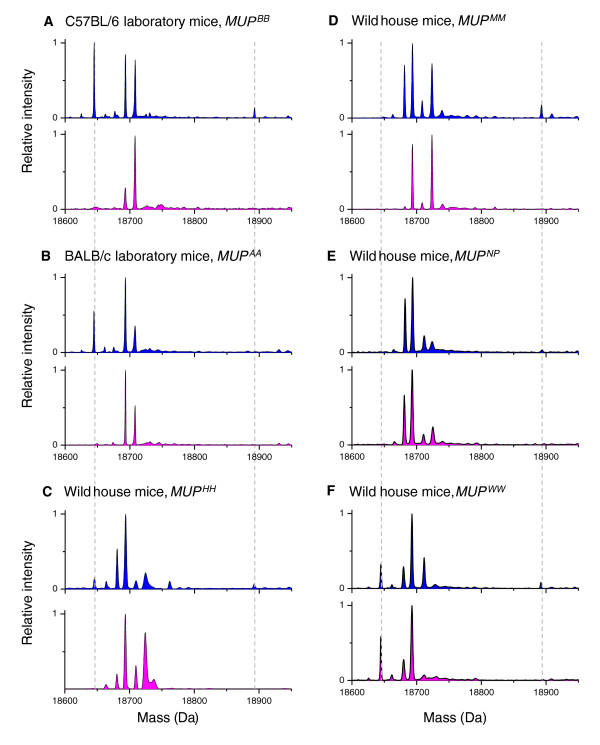
Variation in expression of the 18645Da major urinary protein (MUP) among laboratory and wild mice with different MUP genotypes. Electrospray ionisation mass spectra of urine samples with MUP Intensity expressed relative to the highest peak in each spectrum. Blue: male profiles; pink: female profiles; dashed lines highlight 18645Da and 18893Da. All laboratory mice examined to date exhibit strong male-biased expression of an 18645Da MUP (examples A and B). Some wild mouse MUP genotypes result in similar male-biased expression of an 18645Da MUP (C), some have no detectable expression of this mass (D and E) while some express the protein in both sexes (F). Note that the atypical 18893Da MUP (darcin) does not give a signal on electrospray ionisation mass spectrometry that reflects its abundance.